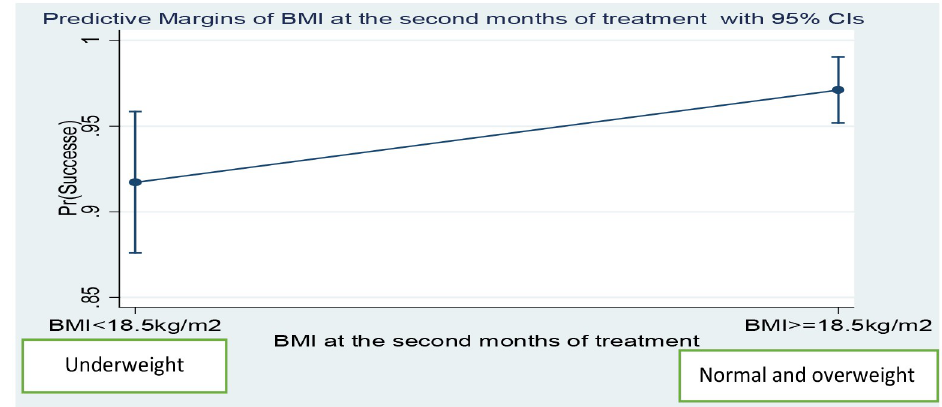
Fig 3. Predicted probability of treatment successes by BMI at the start of treatment among adult TB patients in public health centers of Addis Ababa, Ethiopia, 2019.